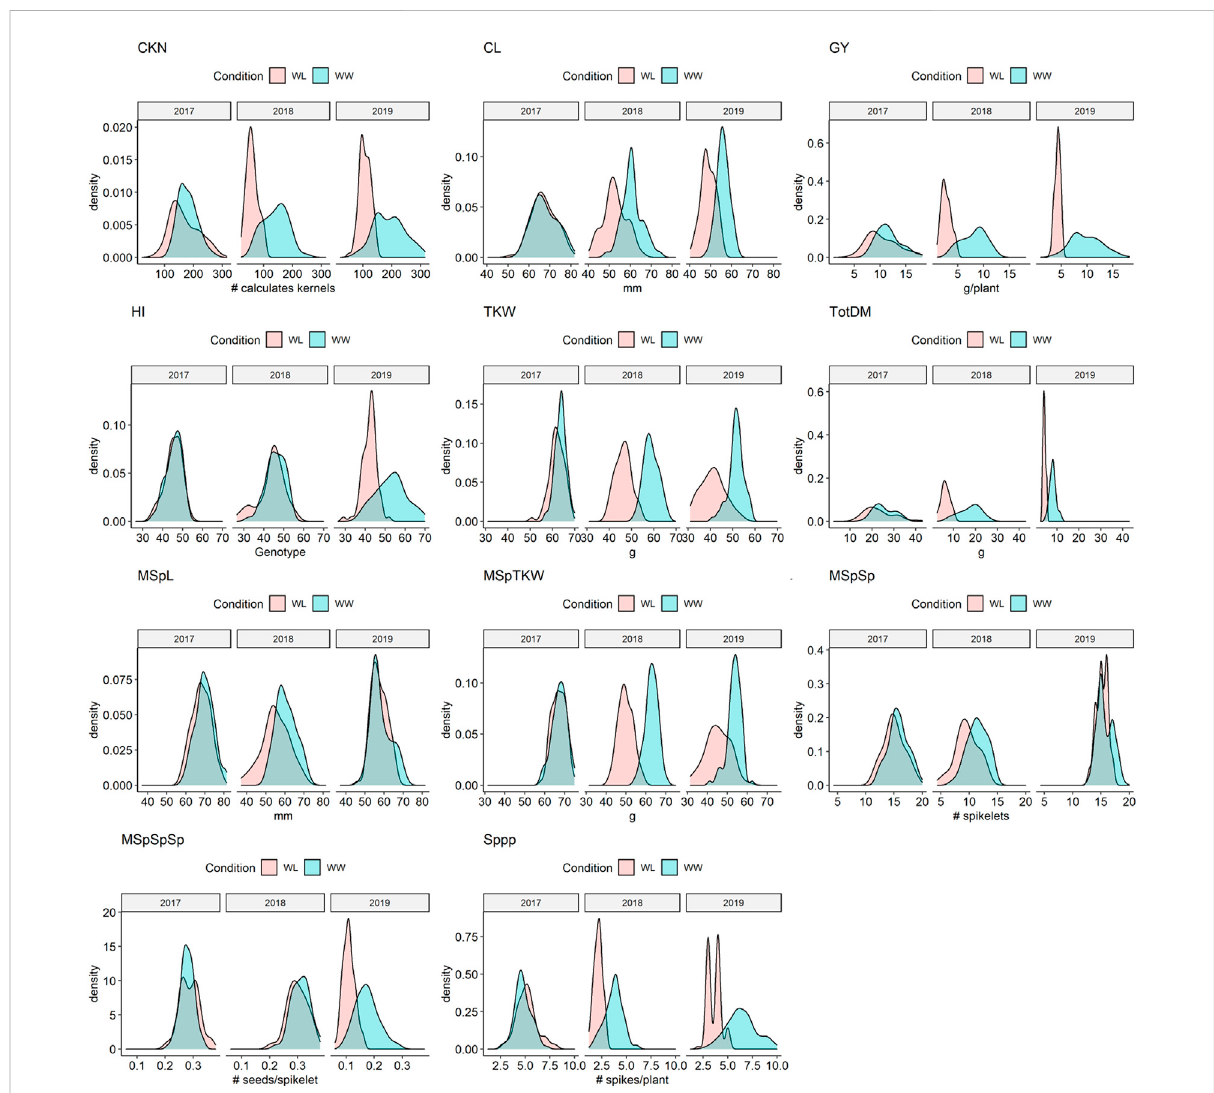
FIGURE 2 Densityplotsofselectedtraitsunderwater-limited(WL)andwell-wateredconditions(WW)in2017,2018,and2019.CKN=Calculatedkernelnumber, CL=CulmLength,GY=Grainyield,HI=Harvestindex,TKW=Thousandkernelweight,TotDM=TotalDryMatter,MSpL=MainSpikeLength,MSpTKW= Main Spike thousand kernel weight, MSpSp = Main Spike Spikelets, MSpSpSp = Seeds per spikelet (of the main spike), Sppp = Spikelets per